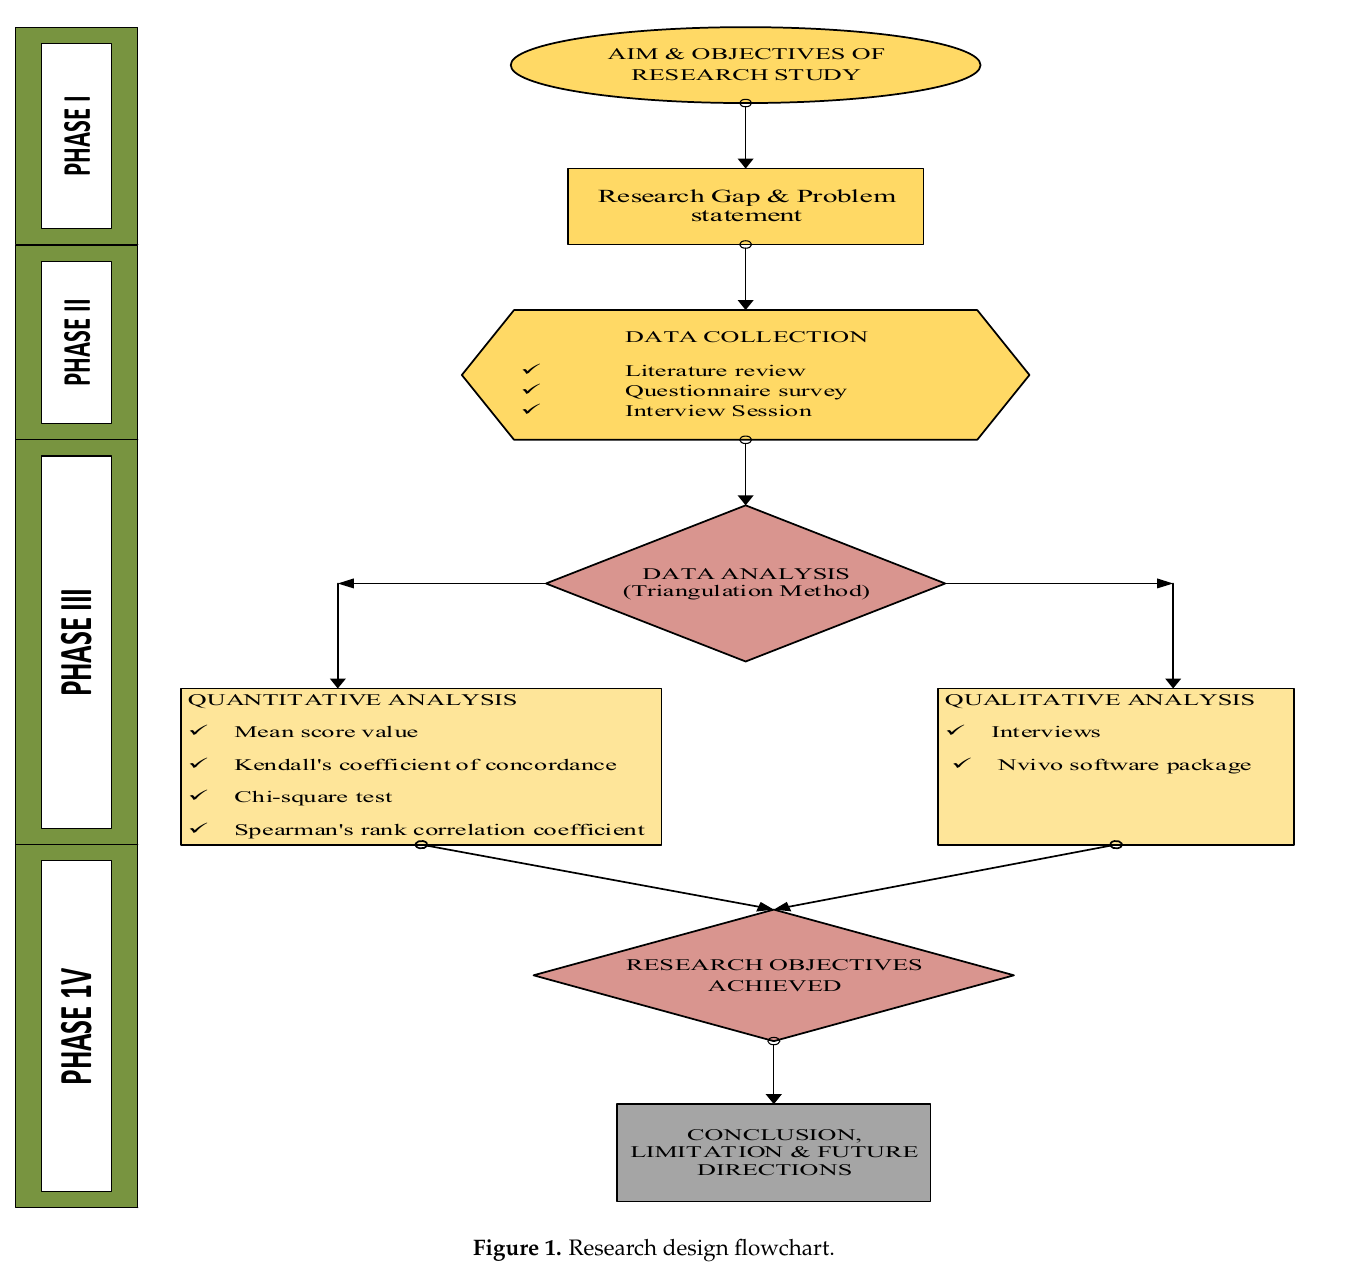
Figure 1. Research design flowchart.